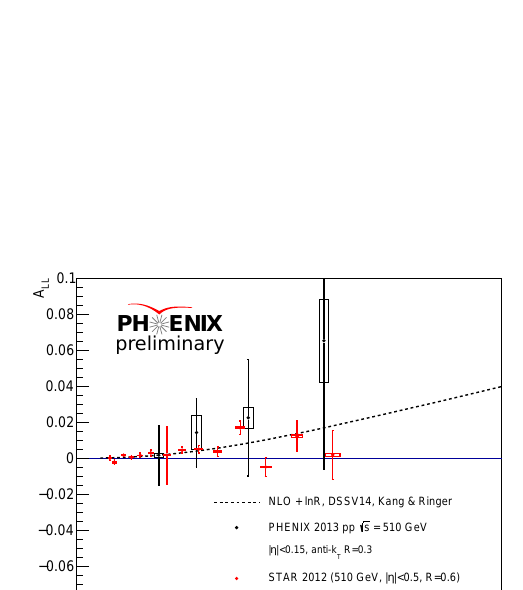
Figure 4: Jet cross section as a function of p compared with NLO pQCD calculations T with ln(R) resummations. The bars represent statistical uncertainties and square brackets are for systematic uncertainties. The bottom plot shows the comparison of data and calculations.